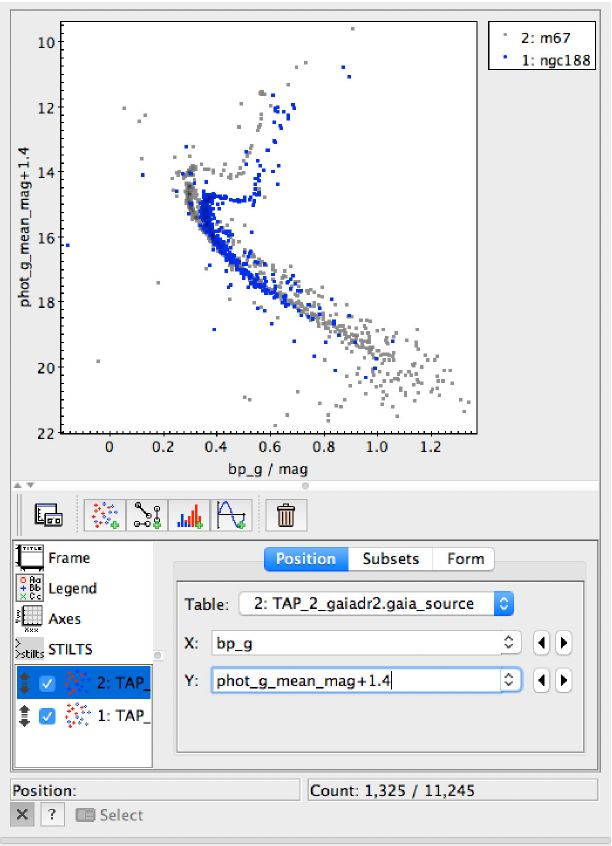
Fig. 74.— Colour-magnitude plots for the open star clusters NGC 188 and M 67 the object’s distance to us (inverse square law).